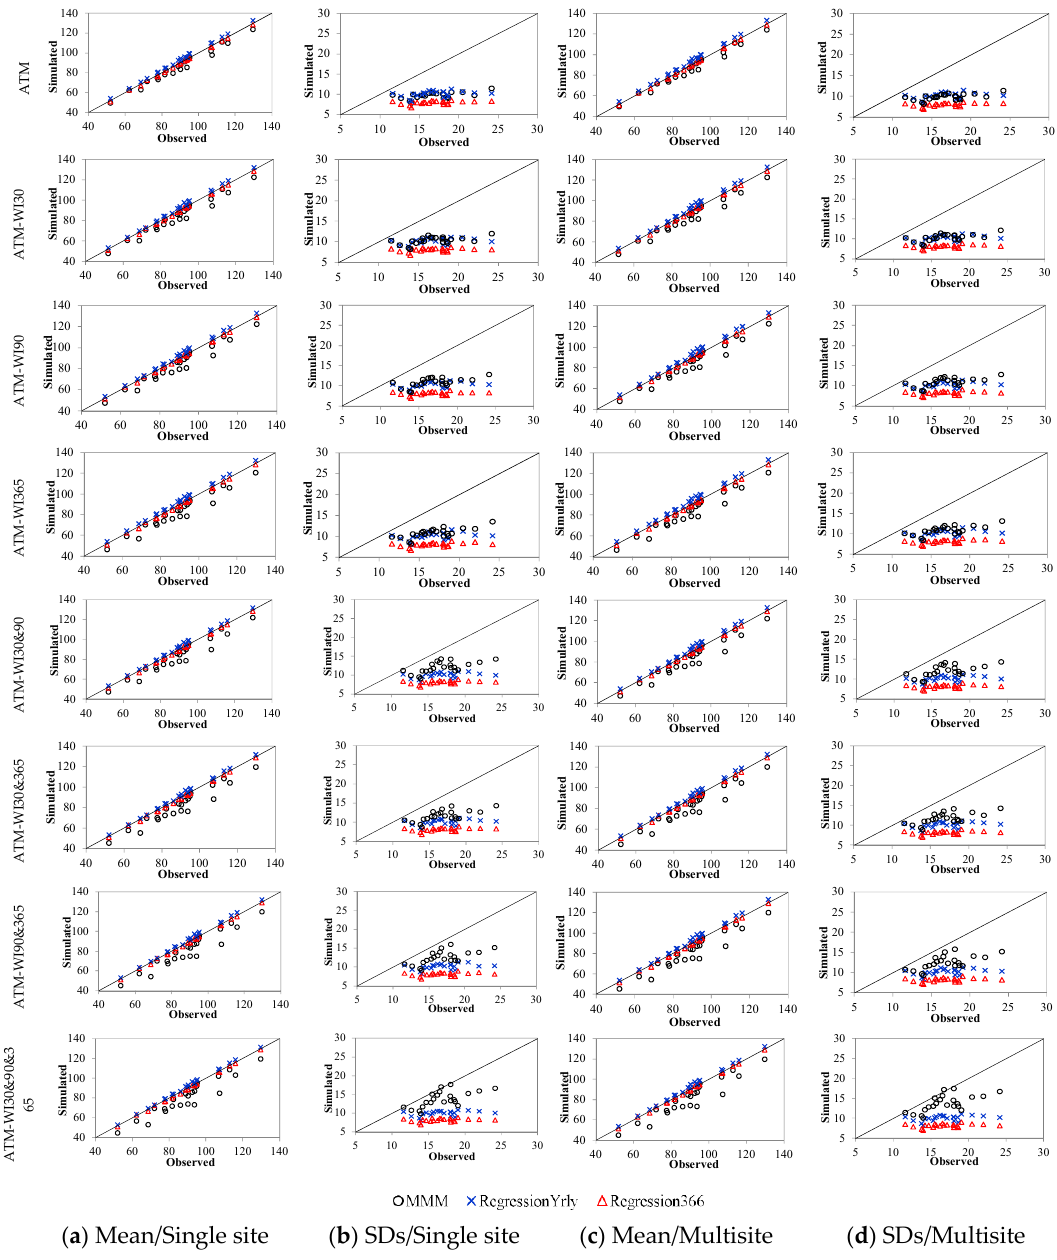
Figure 3. Scatter plots of means and standard deviations of observed and simulated annual wet days at each rainfall station for validation: ( a ) means using single site simulations; ( b ) standard deviations using single site simulations; ( c ) means using multisite simulations; and ( d ) standard deviations using multisite simulations. Each dot on the plot represents a station. Black hollow circles are for MMM, blue crosses are for RegressionYrly and red triangles are for Regression366